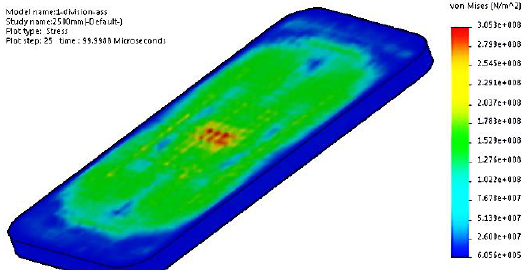
Fig. 3. Stress Distribution for a cellphone with Single Casing at 2500mm Drop Height.